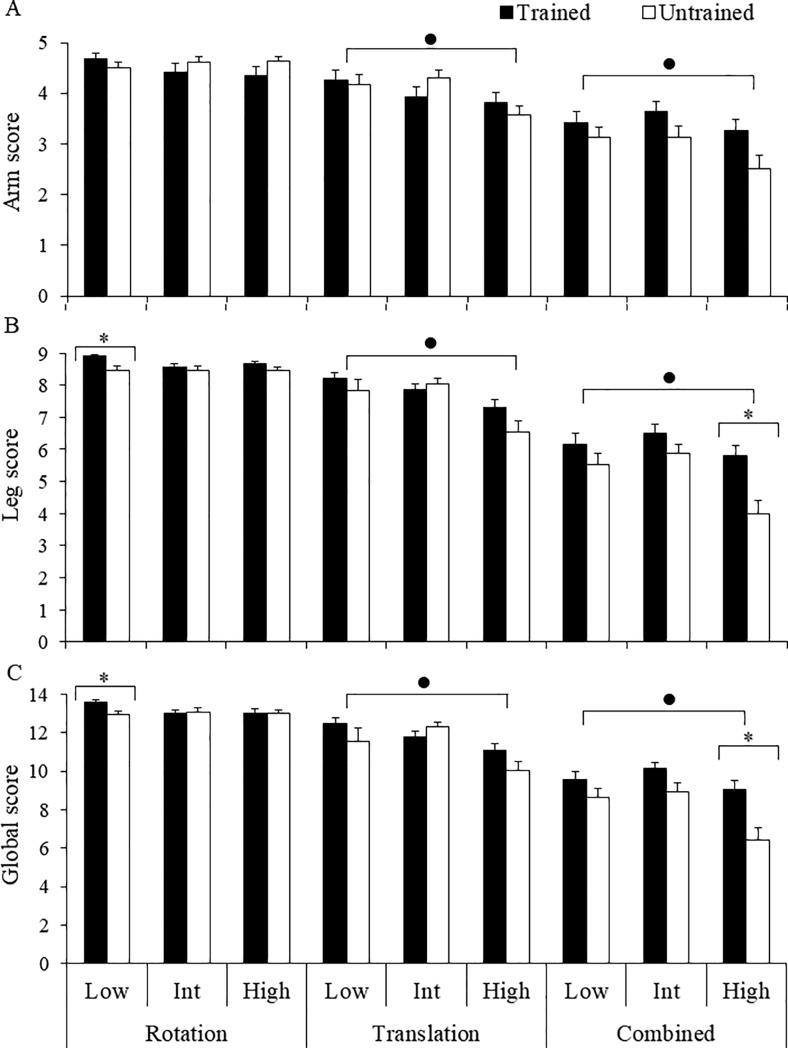
Comparison between the trained and untrained groups.Mean (SE in vertical bars) CALM scale scores for arm (A) and leg (B) compensatory movements, and for the global score (C). Data are presented for rotation, translation and combined perturbations by velocity: low, intermediate (Int) and high, averaged between perturbation directions. Asterisks represent significant differences between trained and untrained groups in specific mode by velocity perturbations, and filled dots represent significant differences between low and high velocity.